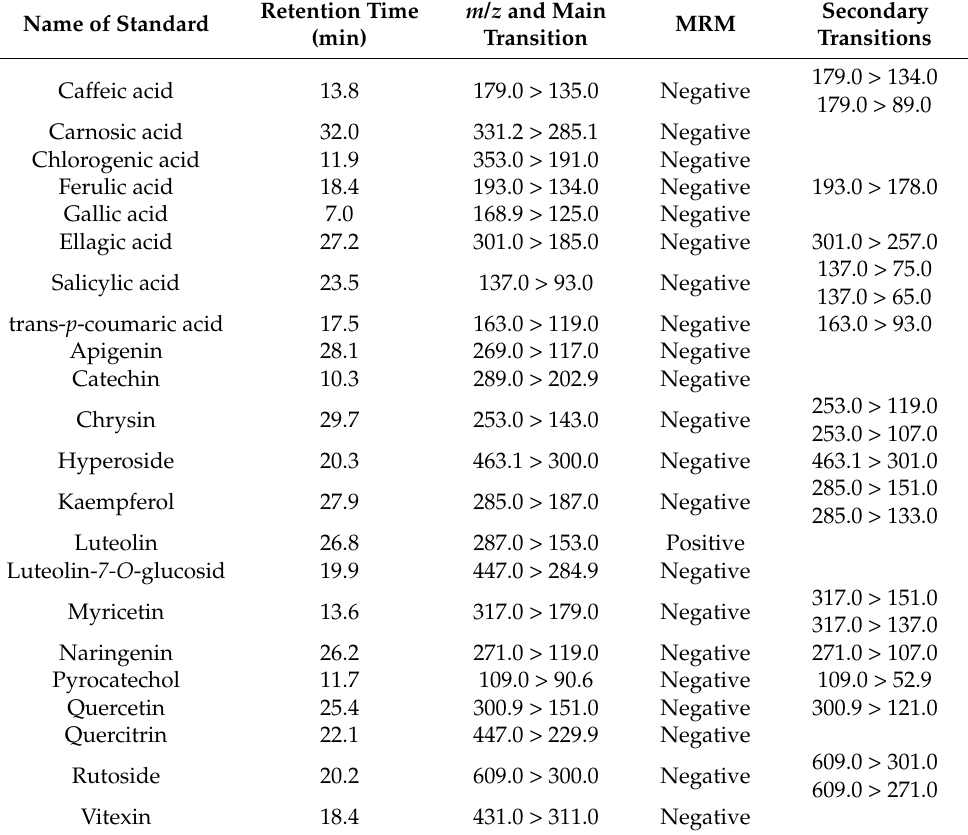
Table 8. LC/MS parameters of the